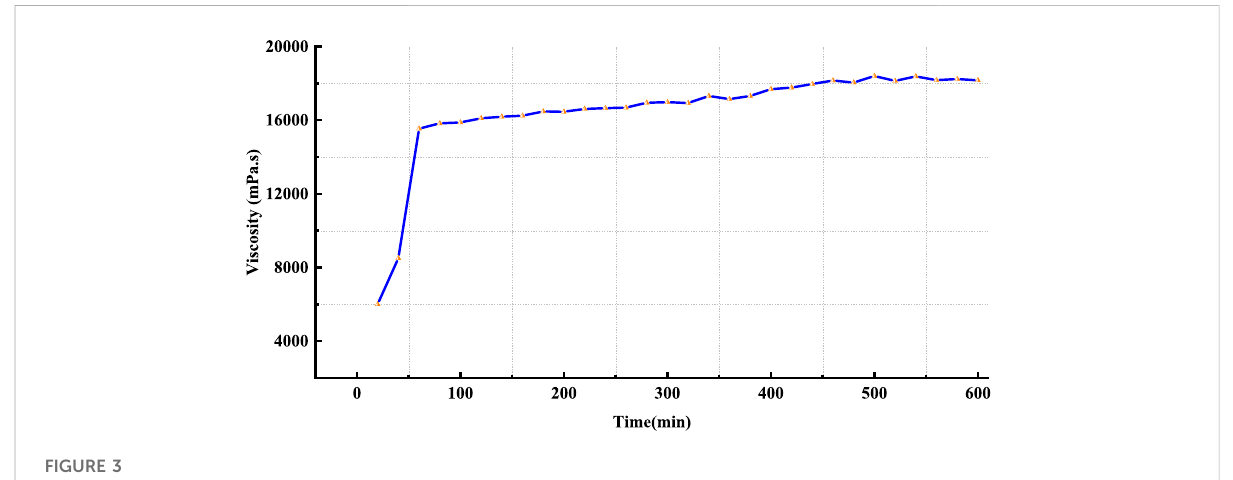
FIGURE 3 Viscosity property change of the samples within 10 h.